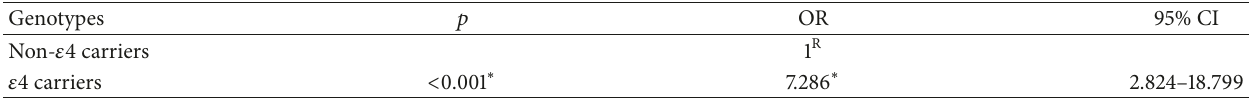
Table 3: Risk association between APOE and